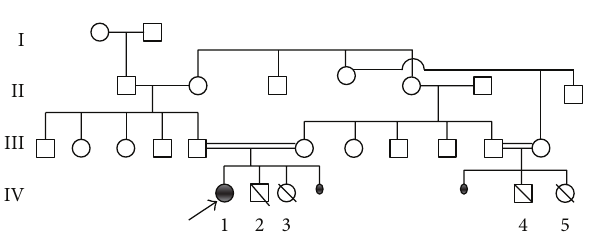
Figure 1: Pedigree of the consanguineous family. Patients’ previous two siblings (IV-2 and IV-3) died at 4 months and 1 year of age due to sepsis and inflammatory bowel disease complicated with sepsis, respectively. She had two cousins who died at early infancy with unknown reasons (IV-4 and